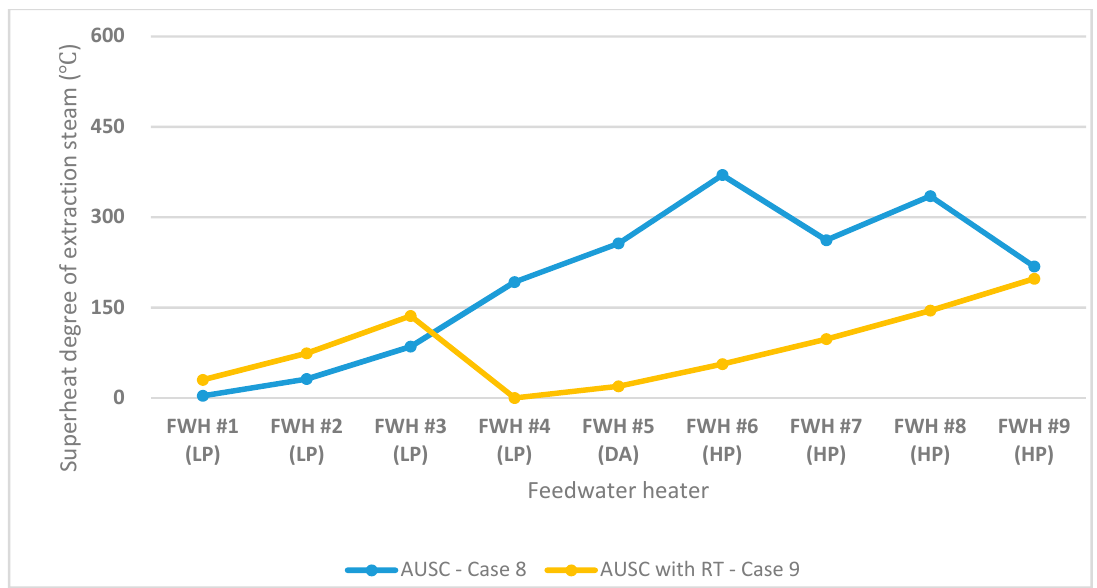
Figure 8. Graphical comparison of overheating of USC & A-USC with RT.